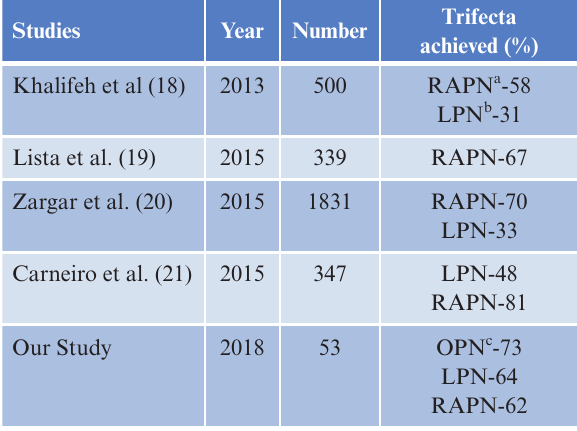
a Robotic-assisted partial nephrectomy. b Laparoscopic-assisted partial nephrectomy. c Open partial